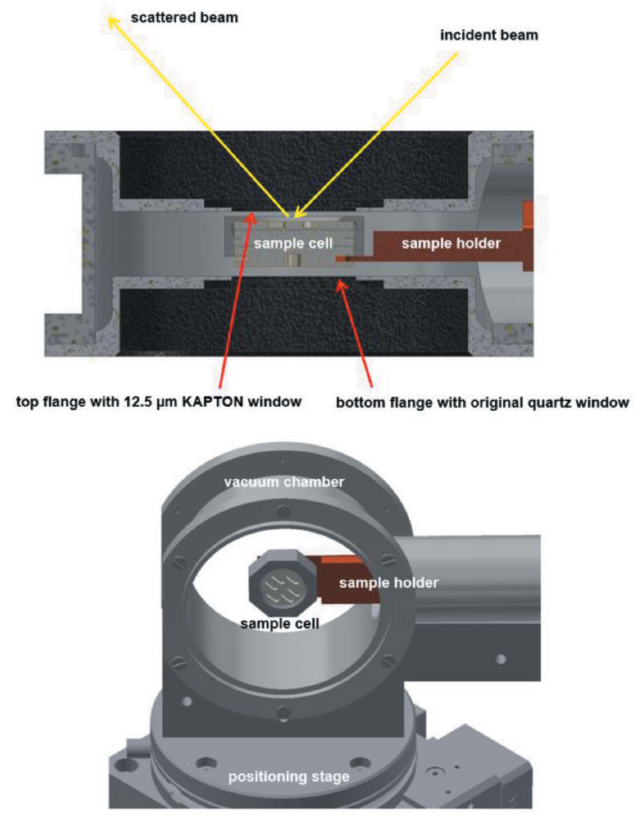
Figure 3 Top – a cross-section CAD drawing of the modified MicrostatHe vacuum chamber (side view). The original sample holder has been replaced by a copper fork clamping the sample cell, as described in Section 4. Bottom – a 3D CAD drawing of the vacuum chamber with removed flanges mounted on top of the positioning stage, exhibiting the sample holder (copper fork) and sample cell assembly.